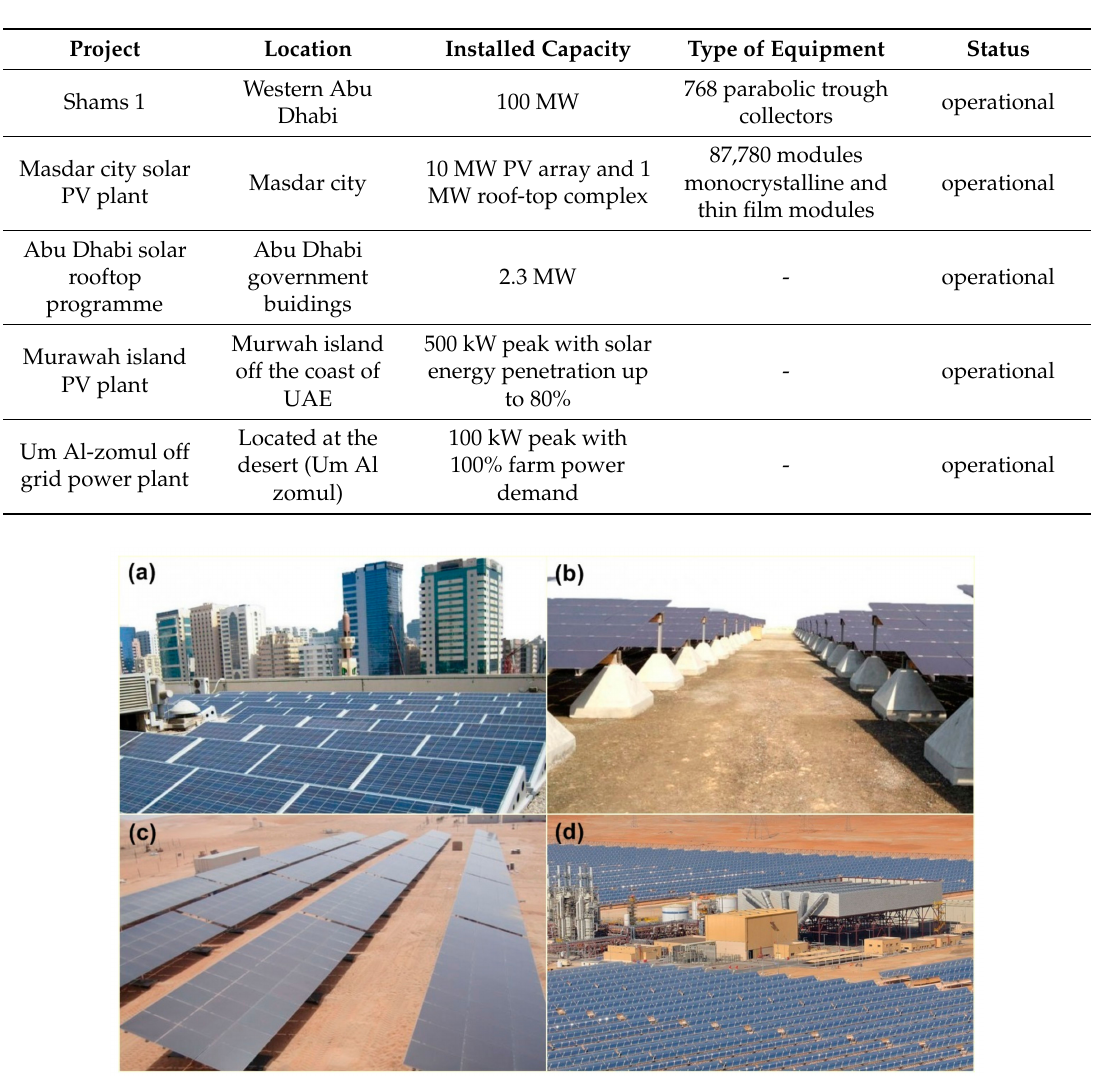
Table 4. Current solar energy plants in the UAE. Adapted from [38].